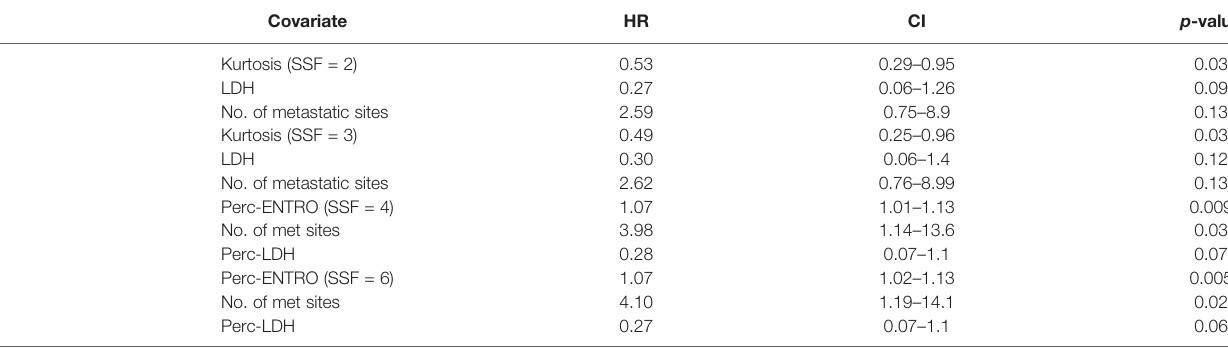
TABLE 4 | (a – d) Multivariate Cox regression analysis including individual signi fi cant univariate texture parameters (selected using LASSO) and clinical variables for predicting PFS. Covariate HR CI p -value